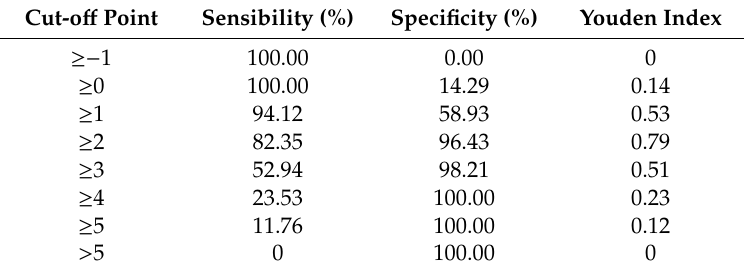
Table 4. Youden index, sensitivity, and specificity of di ff erent cut-o ff points of a score for the early identification of imported arbovirosis infections in febrile ill travelers returning from an endemic country, based on three clinical signs (myalgia + 1 point, rash + 1 point, respiratory symptoms − 1